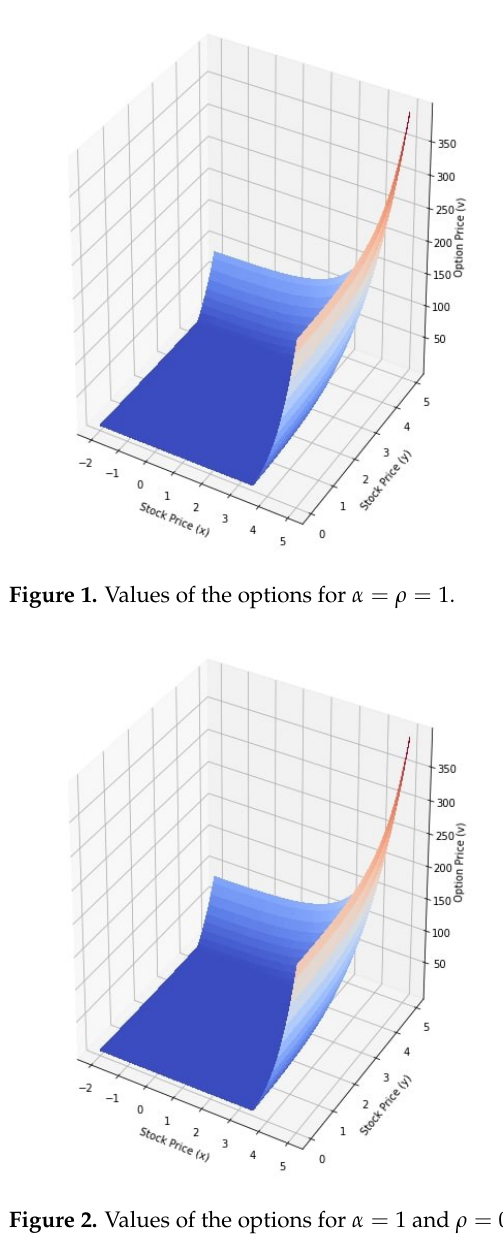
Figure 2. Values of the options for α = 1 and ρ =